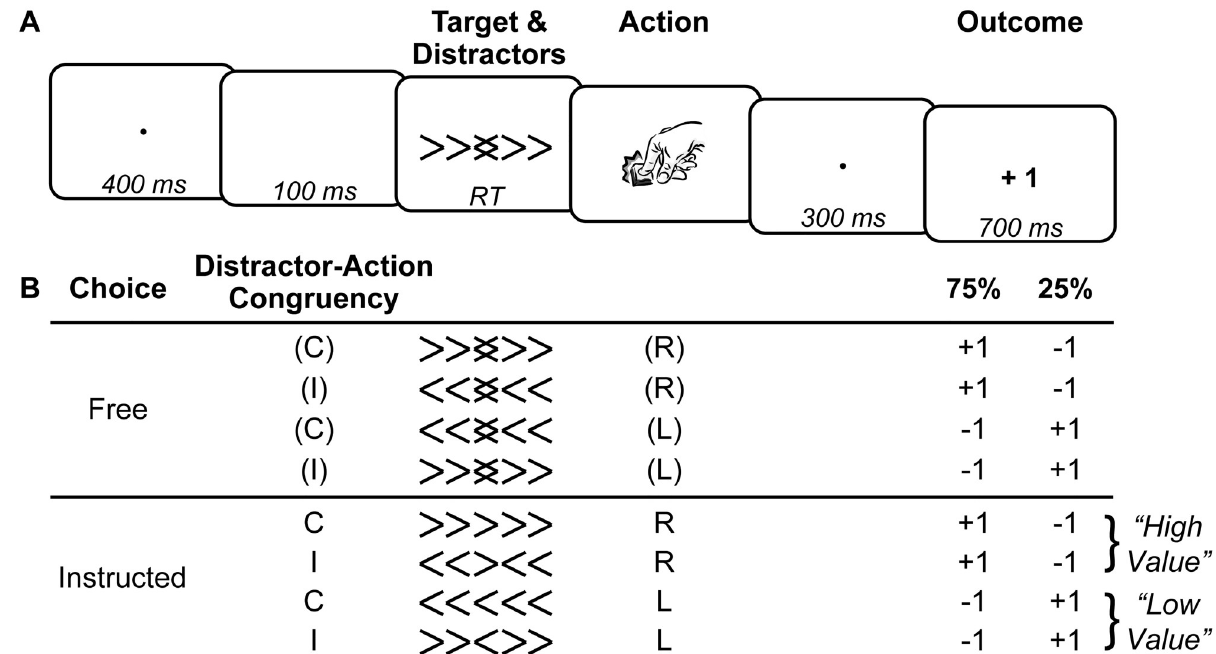
Fig 1. Task outline. A. Timeline of a trial. B. Task design and example mapping of actions to reward probabilities. Conflict between actions and external distractors is captured by the "distractor-action congruency" factor, where C = Congruent, and I = Incongruent. Conflict between instructions and subjective action values (model-based) is exemplified here. Assuming participants correctly learned the current contingency, right (R) would be the subjectively "high value" action (i.e. no conflict if instructed right), and left (L) would be the "low value" action (i.e. conflict if instructed left).